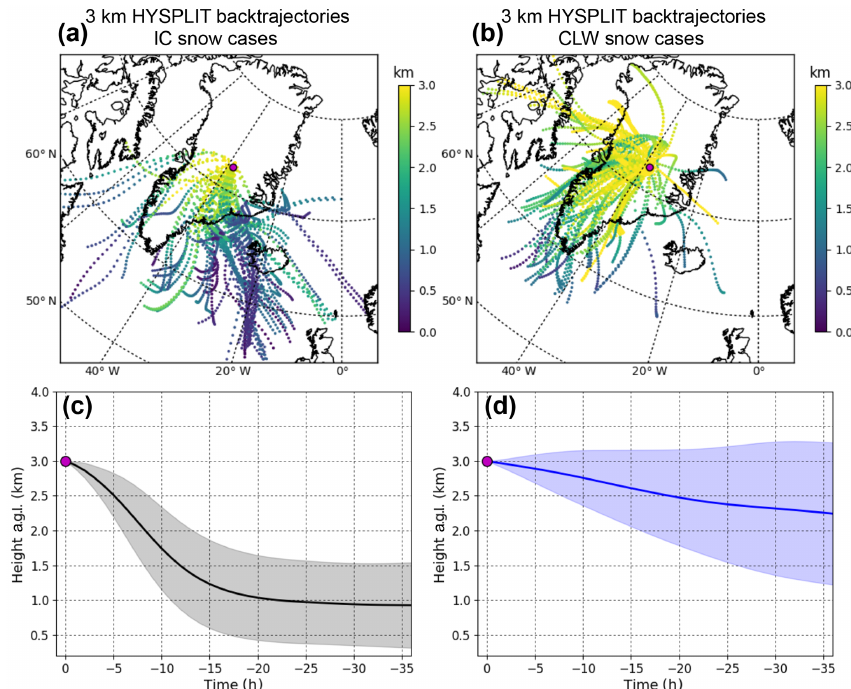
Figure 12. Panel (a) shows the HYSPLIT calculated, 36h back trajectories for the air at 3kma.g.l. originating at Summit using GFS for the IC snow cases. The back trajectory a.g.l. values represent the altitude above ground along each trajectory path. Panel (b) shows the same, but for the CLW cases. Panels (c, d) show the mean vertical motions (dark line) and standard deviation (lighter fill) for the IC and CLW cases, respectively. These are consistent with the previous figures: the IC snow cases being vertically lifted and advected over the GIS from the SE. While the CLW cases come from the S and SW along the mean